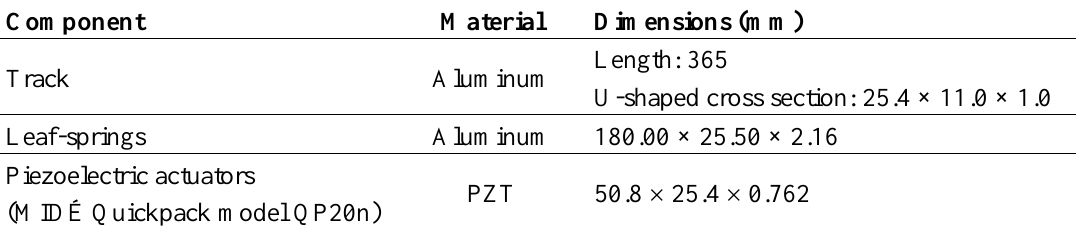
Table 1. Characteristics of the components of the prototype.